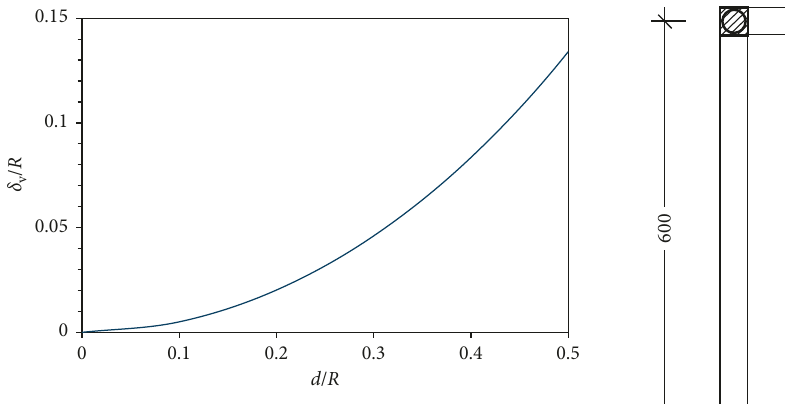
Figure 8: δ R ratio versus d / R v /